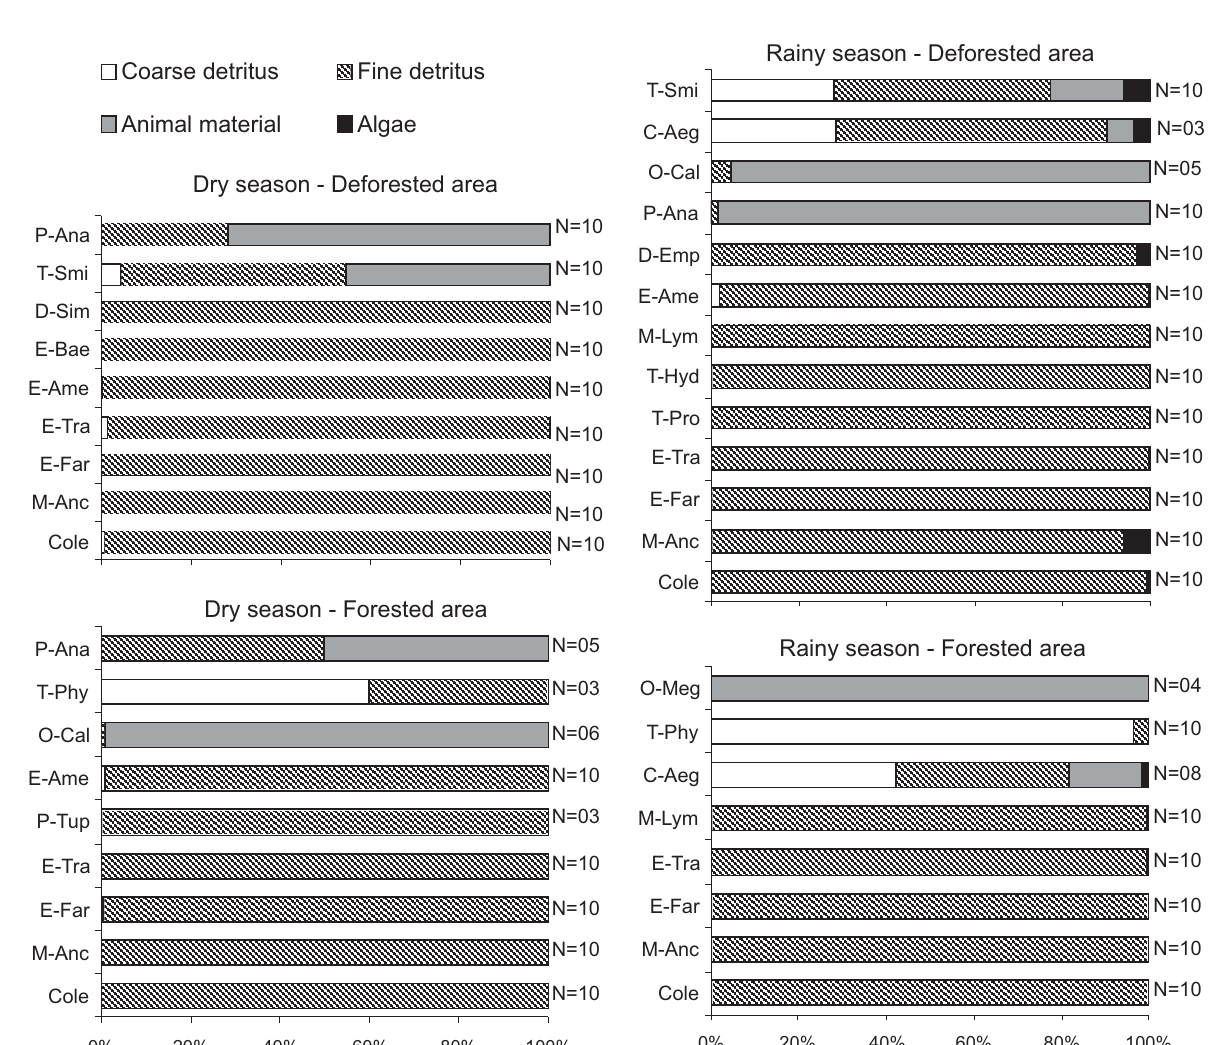
Figure 4. Diet composition (percentage of each food type in the gut contents) of the invertebrates sampled in leaf-bags incubated in the Ribeirão da Quinta stream, during the dry (July 2004) and rainy (December 2004) seasons and at two areas. (C-Aeg) Crustacea- Aegla castro , (Cole) Coleoptera- Heterelmis , (D-Emp) Diptera-Empididae, (D-Sim) Diptera-Simuliidae, (E-Ame) Ephemeroptera- Americabaetis , (E-Bae) Ephemeroptera- Baetodes , (E-Far) Ephemeroptera- Farrodes , (E-Tra) Ephemeroptera- Traverhyphes , (M-Anc) Mollusca-Ancylidae, (M-Lym) Mollusca-Lymnaeidae, (O-Cal) Odonata- Hetaerina , (O-Meg) Odonata- Heteragrion , (P-Ana) Plecoptera- Anacroneuria , (P-Tup) Plecoptera- Tupiperla , (T-Hyd) Trichoptera- Hydroptila , (T-Phy) Trichoptera- Phylloicus , (T-Pro) Trichoptera- Protoptila , (T-Smi) Trichoptera- Smicridea . N = number of dissected individuals that presented some material in the